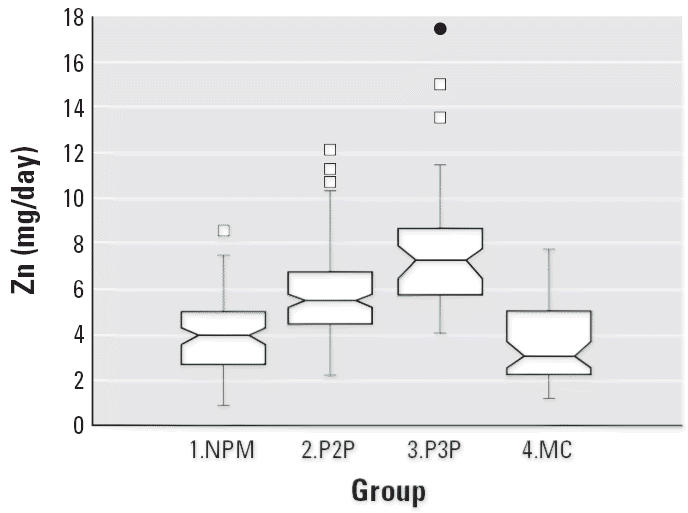
Notched box plot for descriptive statistical data showing daily intakes
of Zn from 6-day duplicate diets. The recommended daily intake for such
females is 16–19 mg Zn (National Research Council 1989).